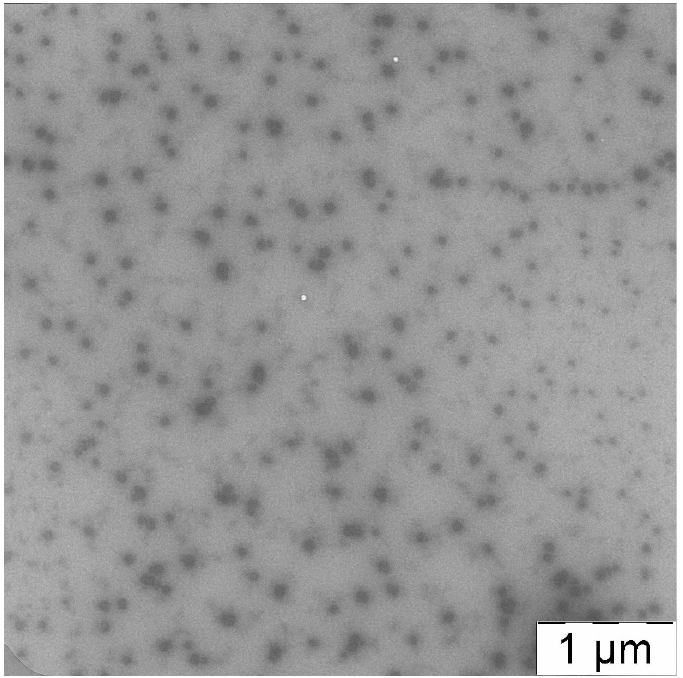
Figure 13. TEM image of PLAMs–PTX.